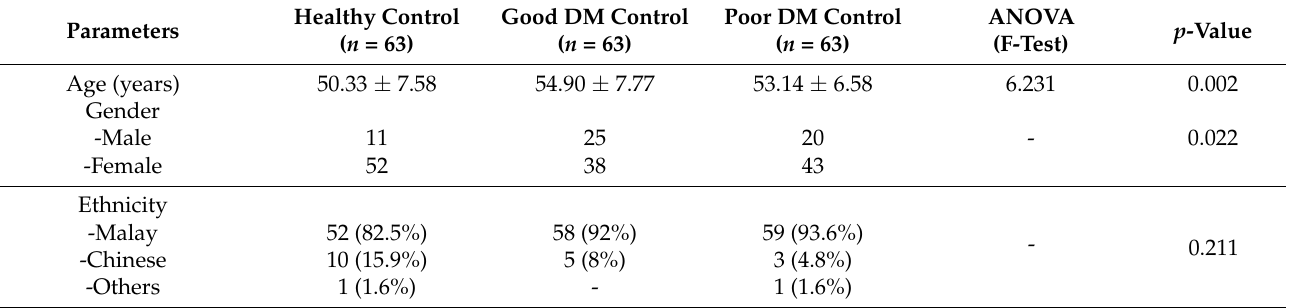
Table 2. Demographic and biochemical